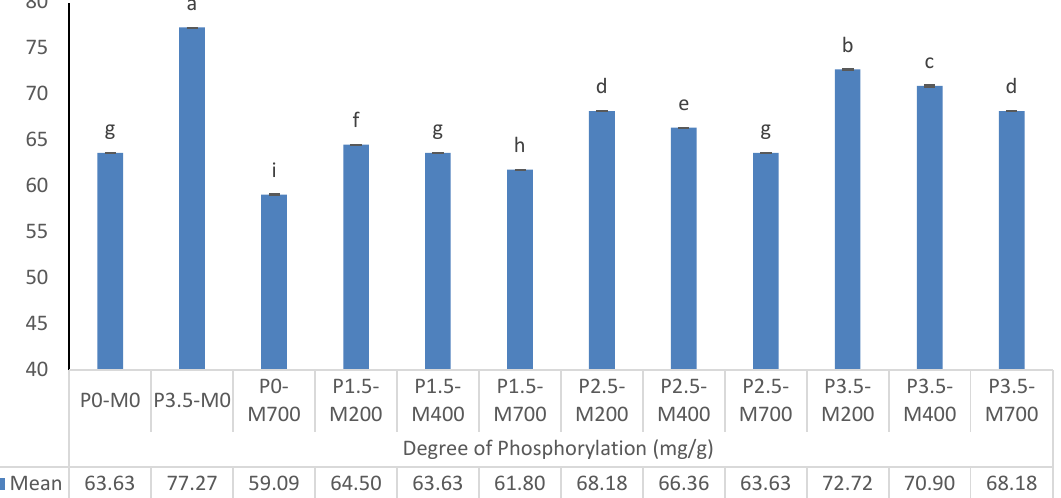
Figure 6. The effect of phosphorylation (%) and microwave power (W) on degree of phosphorylation of egg white powder. Means ( n = 3) with different letters in each column indicate significant difference ( p < 0.05).